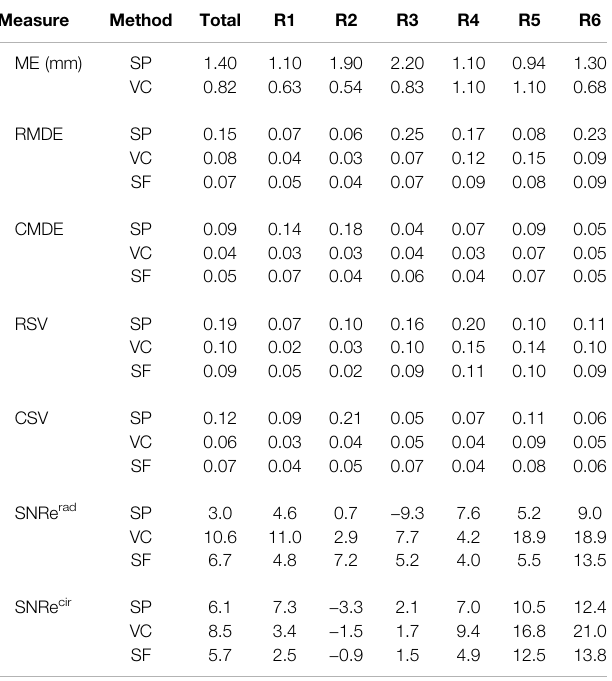
TABLE 2 | Quantitative results of motion tracking and strain estimation for myocardium (R1-R6). Measure